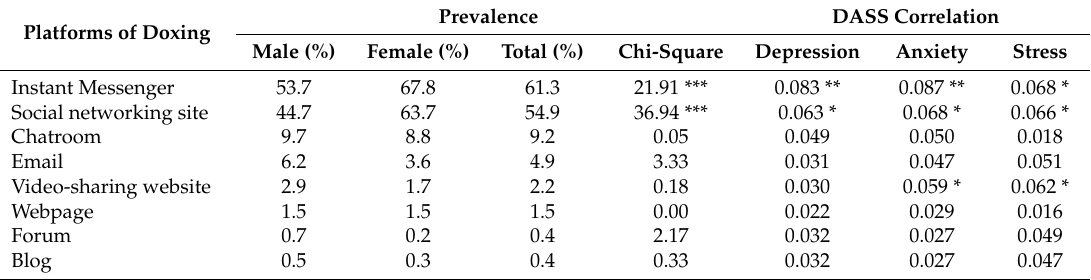
Table 3. Platforms of doxing and associations with DAS of victims ( n = 2120). Prevalence DASS Correlation Platforms of Doxing Instant